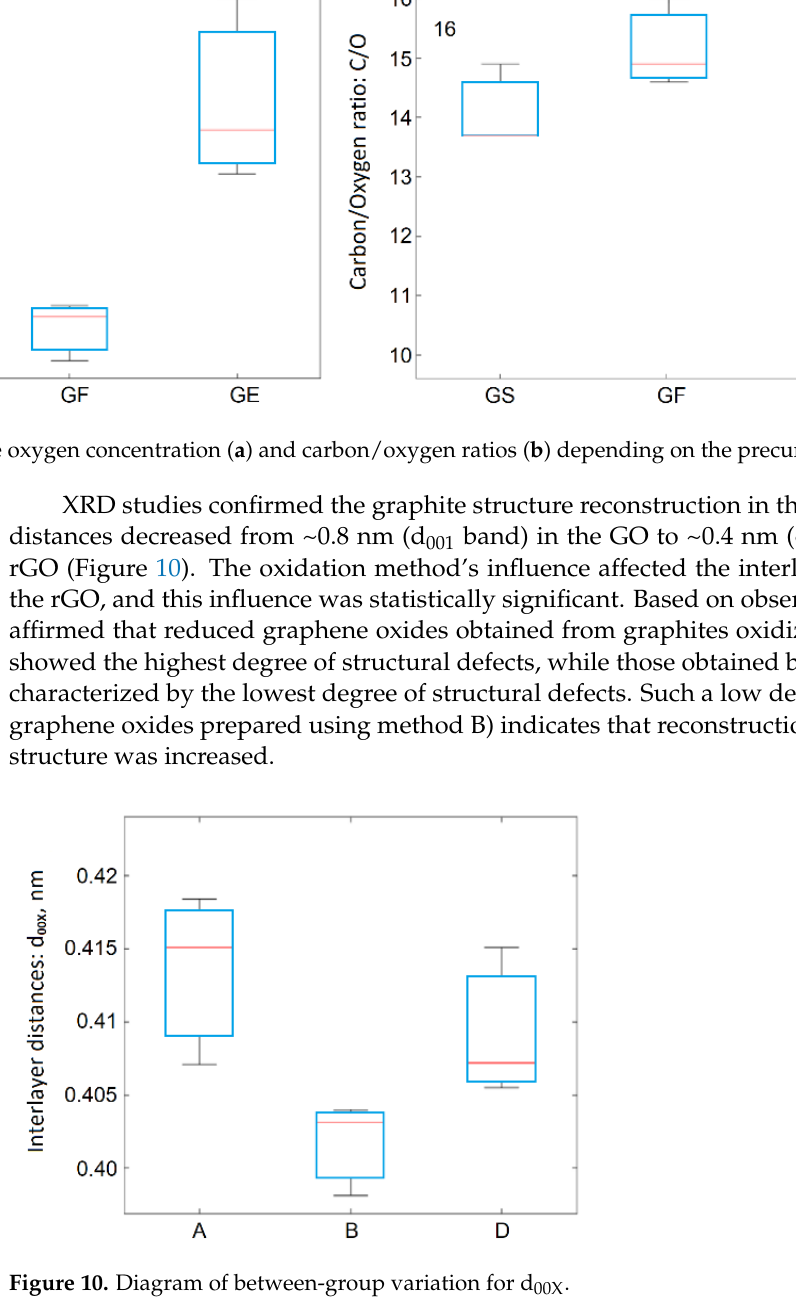
Figure 10. Diagram of between-group variation for d 00X.